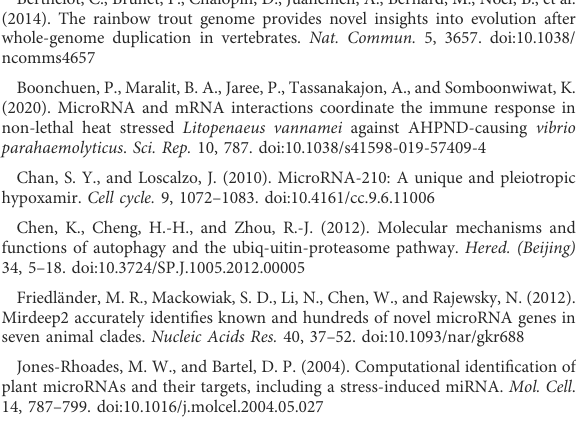
SUPPLEMENTARY FIGURE S1 PCA analysis of six body wall libraries in Apostichopus japonicas . SUPPLEMENTARY FIGURE S2 Length distribution of valid reads in six libraries in the body wall of Apostichopus japonicas . SUPPLEMENTARY FIGURE S3 Families and members distribution of known